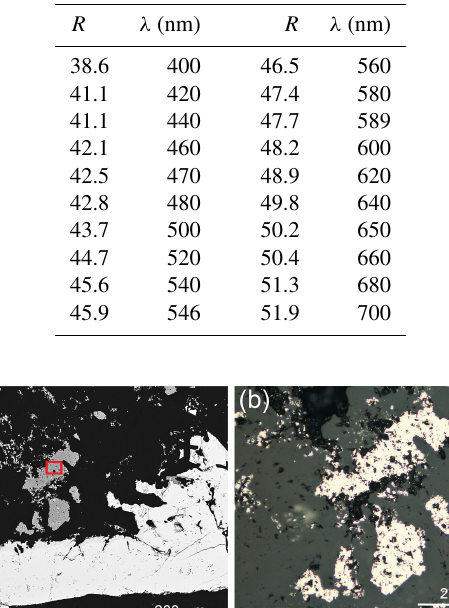
Table 1. Reflectance values (%) for grimmite.